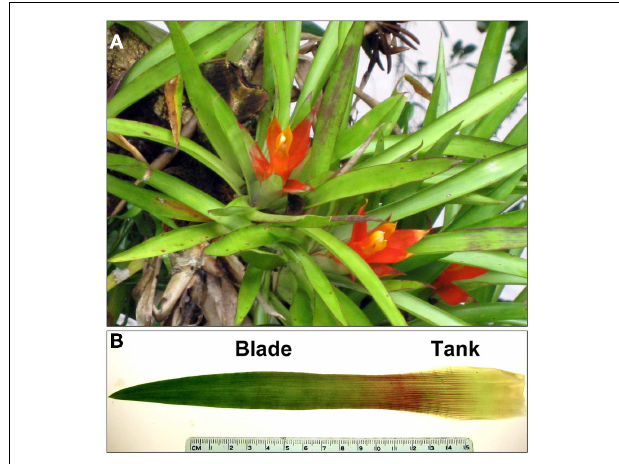
FIGURE 1 | (A) Plants of Guzmania lingulata in the field at La Selva biological Station, Costa Rica, and (B) a single leaf of G. lingulata labeled with the two leaf regions